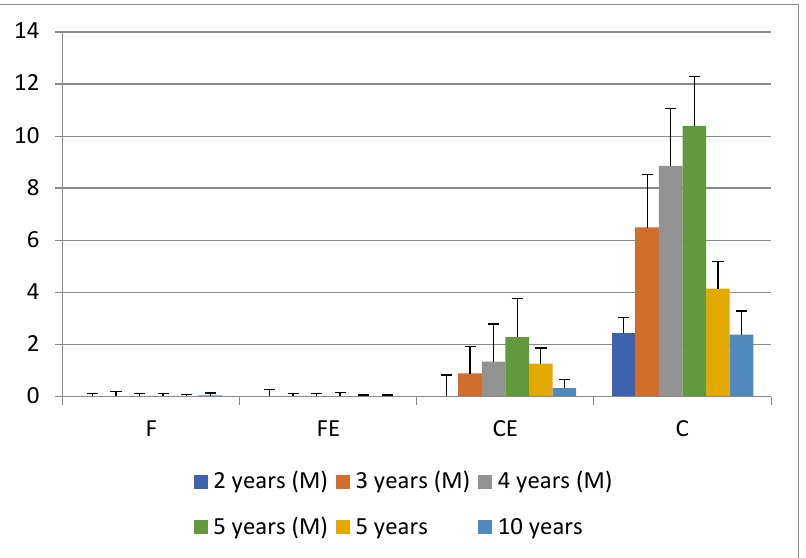
Figure 3. Changes in the average percentage cover of Epilobium angustifolium in ecotone complex zones (F—forest, FE—forest edge, CE—clear-cut edge, C—clear-cut) during the study period (M—revisited monitoring sites (2nd to 5th post-clear-cutting years)). Mean values and standard errors are shown.